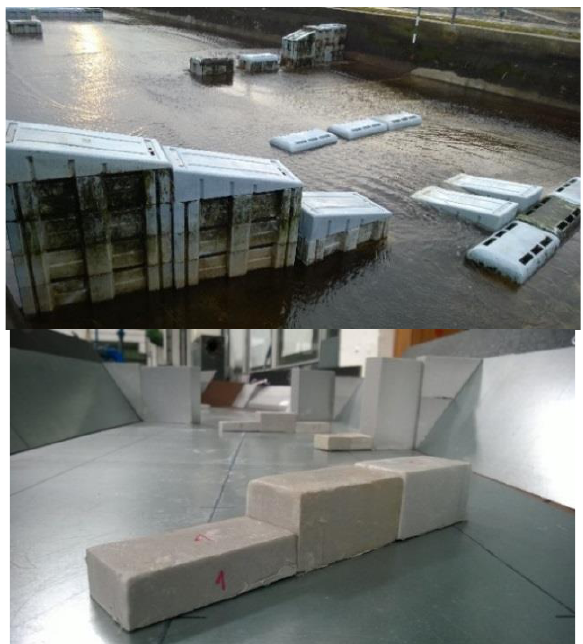
Figure 10. a, b Examples of obstacles – real life (Prague-Troja) and scaled 1 :13 model; bottom covered with steel plates; each obstacle had Nd magnets in lower part of